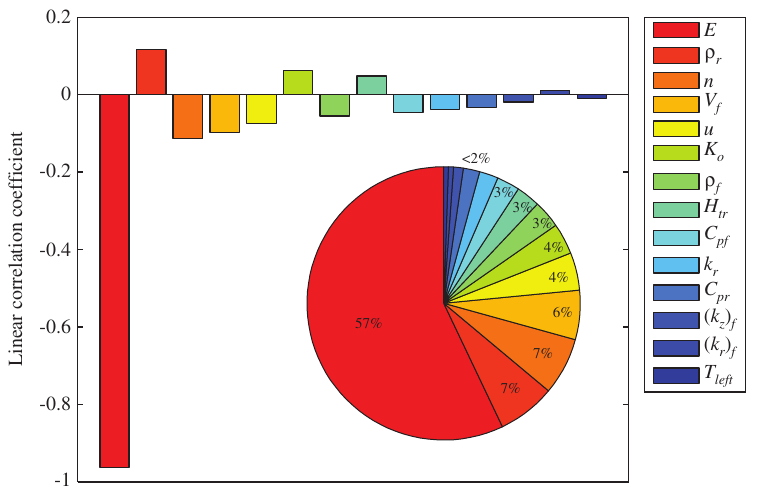
Figure 6 Linear correlation coefficients between the RIPs and the CDOCE in the bar plot and corresponding sensitivities in the pie chart for case 2.1.